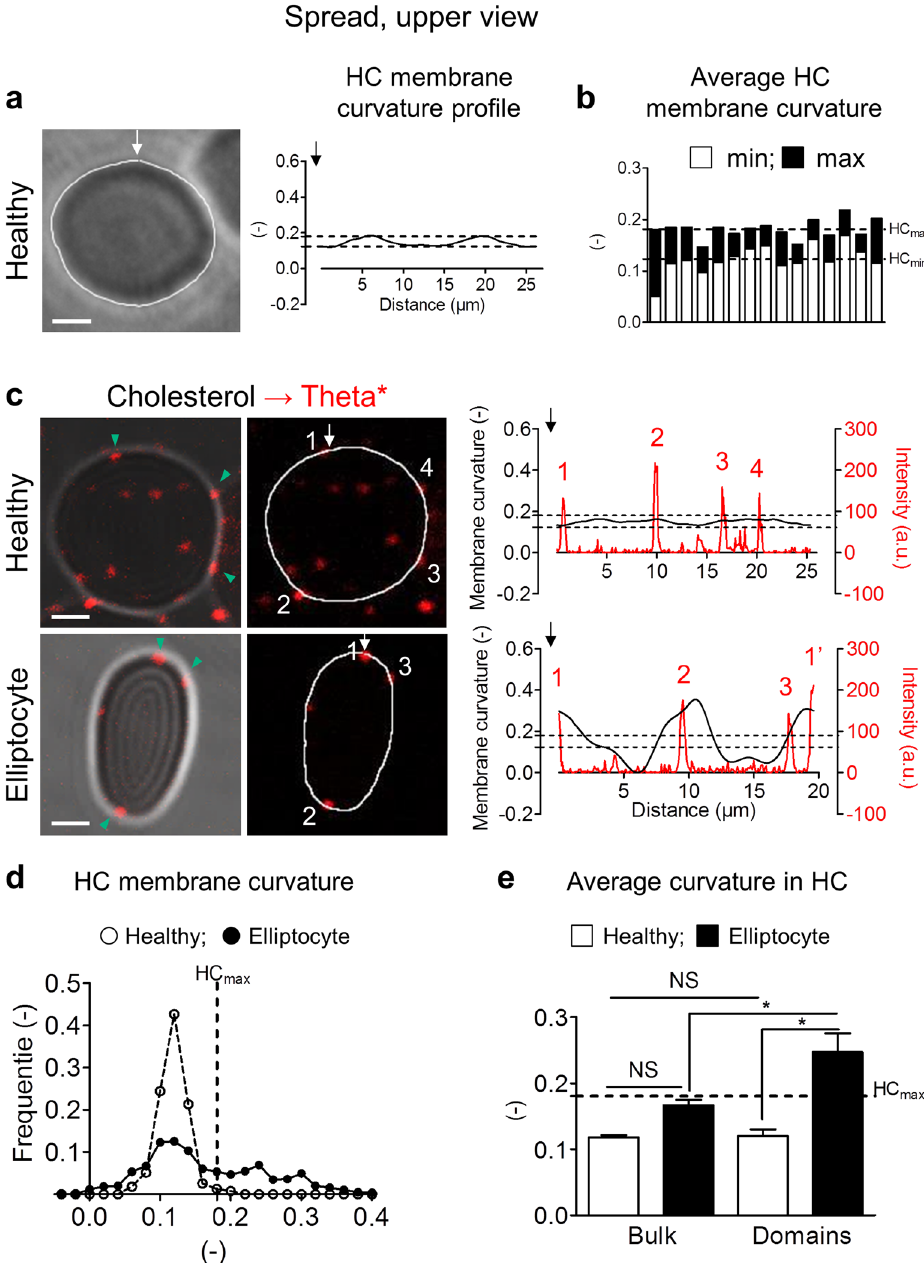
Figure 3. Preferential association of chol-enriched domains with increased curvature areas in the rim of elliptocytes. Fresh healthy and elliptocytotic RBCs were labelled ( c–e ) or not ( a,b ) with Theta * , washed, spread and observed in upper view as in Fig. 1. ( a ) Representative phase contrast image ( left panel) and membrane curvature profile along path indicated in left panel by white curved line ( right panel) . Profile is going counterclockwise from starting point indicated by white arrow . Representative of three independent experiments, s cale bar 2 µ m. ( b ) Quantification of minimum and maximum membrane curvature values. Dashed lines represent the average minimum and maximum curvature values of 15 side viewed RBCs (0.12 for HC min and 0.18 for HC max ). ( c ) Representative vital confocal imaging of Theta * -labelled RBCs ( left & central panels; green arrowheads indicate domains in HC membrane areas) and relation between Theta * intensity ( red ) and membrane curvature ( black ) on profiles along paths indicated in central panel by white curved lines starting by white arrows (right panel) . Domains ( red numbers ) are labelled with white numbers in central panel; dashed lines represent HC min and HC max calculated in ( b ). Representative of four independent experiments, s cale bars 2 µ m. ( d , e ) Quantification of curvature value distribution of HC membrane ( d ) and average curvature values of HC bulk and domains ( e ) calculated on profiles of healthy RBCs ( open symbols and bars ) and elliptocytes ( black symbols and bars) . Results are means ± SEM of 4–10 RBCs from two independent experiments. Statistical significance was tested with one-way ANOVA followed by Tukey’s post-hoc